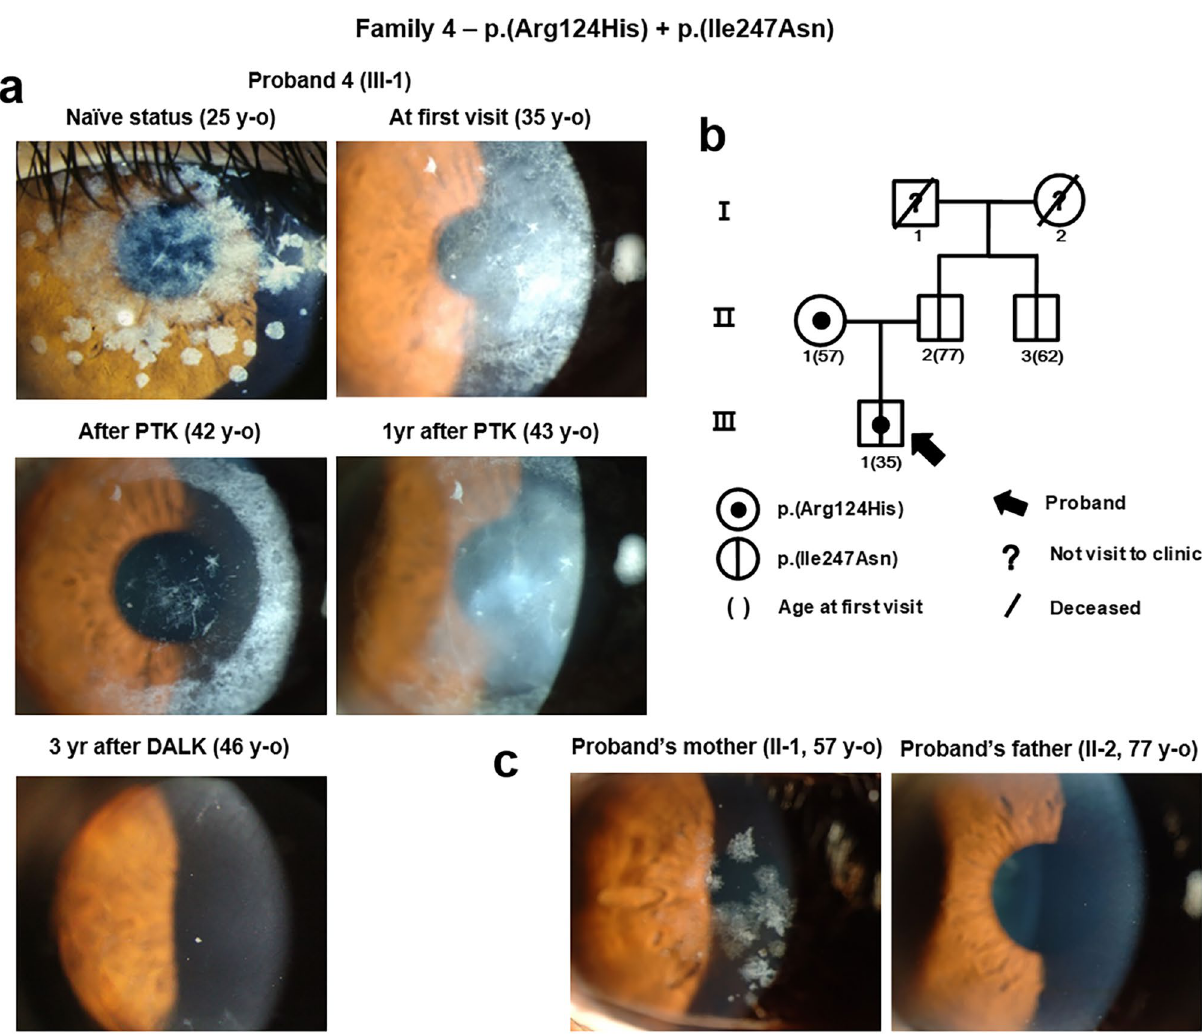
Figure 2. Compound heterozygous mutations, p.(Ile247Asn) and p.(Arg124His), in TGFBI . ( a ) Slit-lamp photographs of Proband 4 (Family 4). Intensive snowflake-like corneal deposits were noted at the age of 25 years, and rapid recurrence occurred after phototherapeutic keratectomy (PTK). Following deep anterior lamellar keratoplasty (DALK), the cornea has been well-maintained since the past 3 years. ( b ) Pedigree of Family 4 confirmed compound heterozygosity. ( c ) Slit-lamp photographs of the parents of Proband 4. The mother, who only had heterozygous p.(Arg124His) mutation in TGFBI , showed milder phenotypes than the son, and the father, who had heterozygous p.(Ile247Asn) mutation in TGFBI , showed a clear cornea. Although TGFBI p.(Ile247Asn) mutation itself was silent, when accompanying p.(Arg124His) mutation, phenotypes of granular corneal dystrophy 2 became extensive and recurrence occurred rapidly after